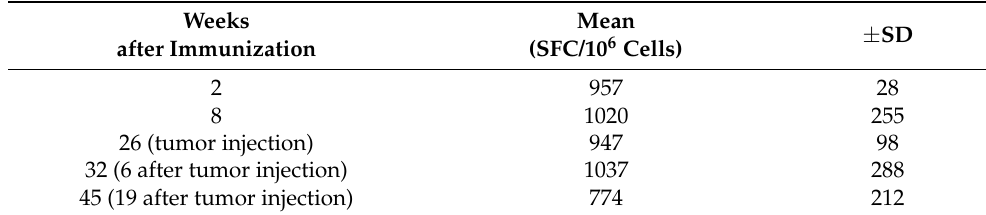
Table 1. Kinetics of OVA-specific T cell immune response evaluated in mice immunized with IDLV-OVA and injected with B16OVA by IFN γ